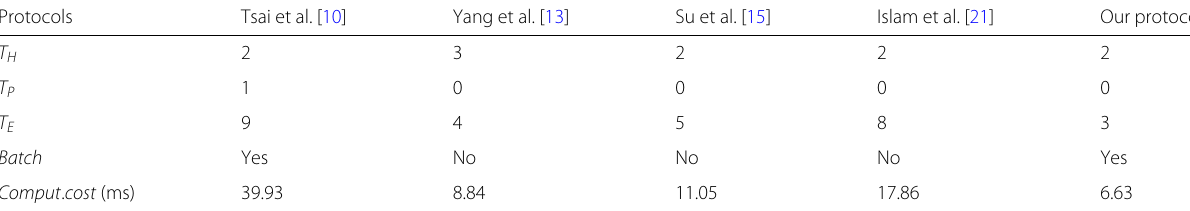
Table 1 Performance analysis and comparison of each protocol